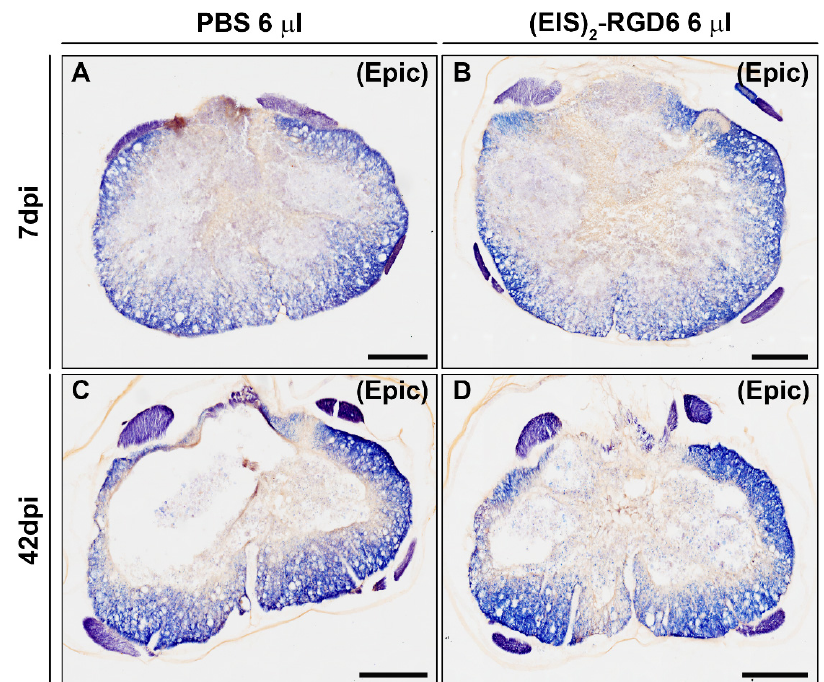
Figure 17. Representative images from eriochrome cyanine (Ecy) stained sections. Representative images of Ecy stained spinal cord sections corresponding to the lesion epicentre, used to carry out the densitometrical analysis of myelin preservation in experiment (EIS) 2 -RGD6 III at 7 and 42 days post-injury (dpi): ( A ) PBS 6 µL group at 7 dpi; ( B ) (EIS) 2 -RGD6 6 µL group at 7 dpi; ( C ) PBS 6 µL group at 42 dpi; and ( D ) (EIS) 2 -RGD6 6 µL group at 42 dpi. Scale bars, 500 µm. Please note that data obtained from the densitometric analysis of myelin preservation in these sections can be found in Figure 16A,B.